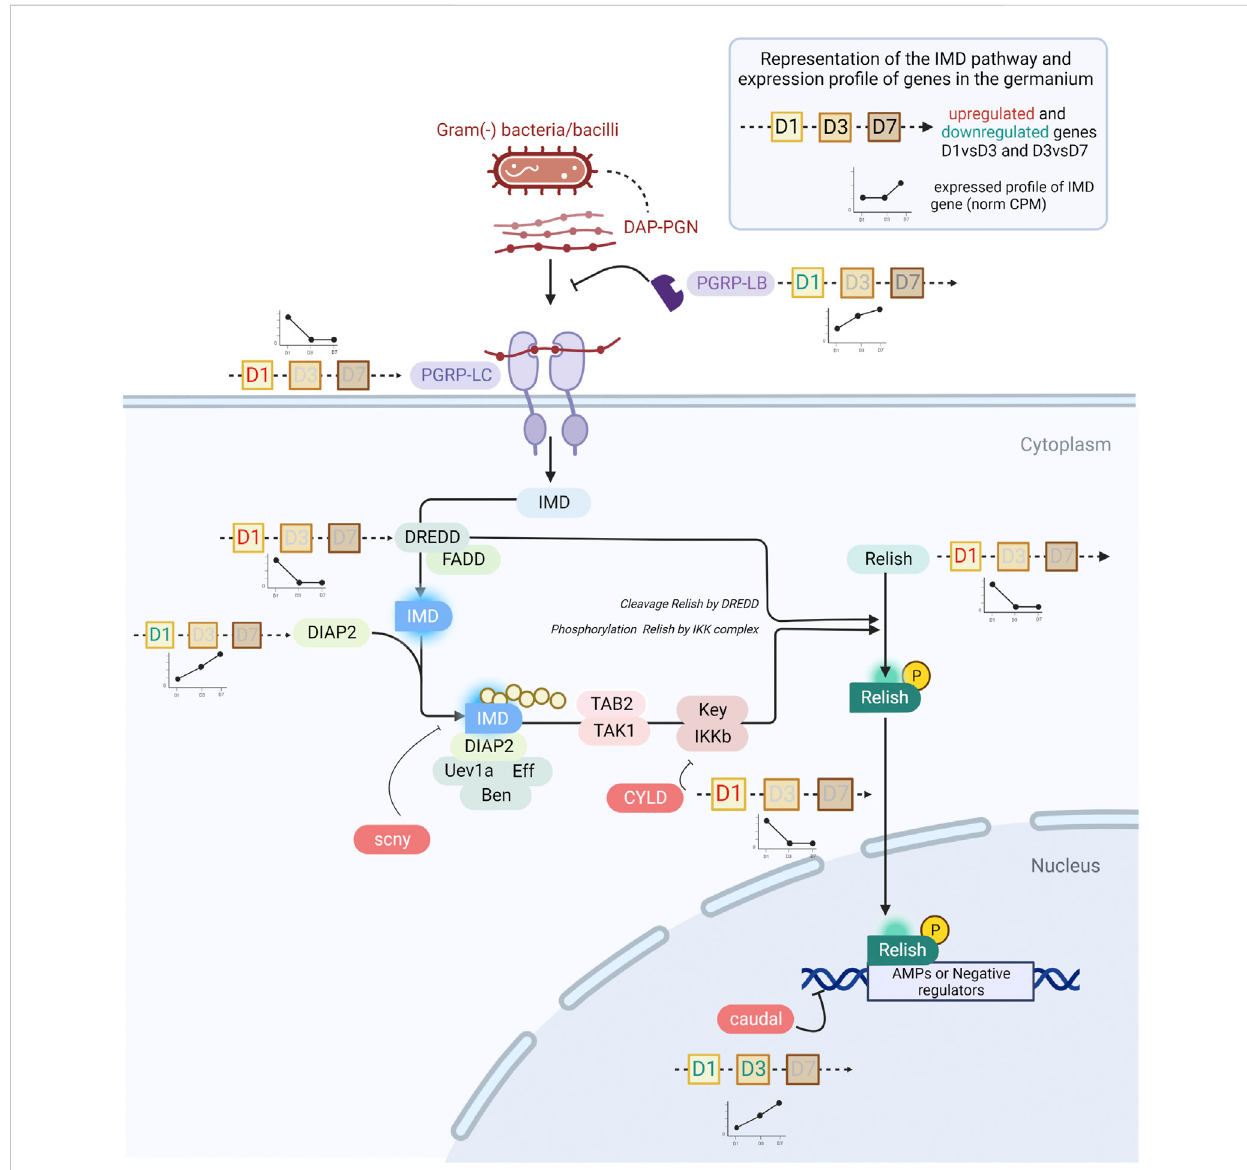
FIGURE 5 TheIMDpathwayin S.oryzae during germariumdevelopment.Theexpressionpro fi leofgenesisdepictedbylinehistogramsandbasedonFigure4. Thetimepointsstudiedaredepictedassquares,withD1,D3orD7writteninside.Redletterscorrespondtotheupregulationofthegeneatthatstage,and green blue letters depict downregulation. In pre-emerged females, the IMD pathway is active and AMPs are abundantly produced. In one-week-old females, caudal is upregulated and consequently represses relish expression, potentially causing downregulation of AMPs. Finally, pgrp-lb is constantly expressed across time points, insuring cleavage of monomeric TCT and avoiding reactivation of the IMD pathway by